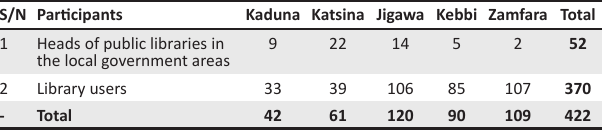
TABLE 2: Sample size of the study: Proportionate sample from each state under study. S/N Participants